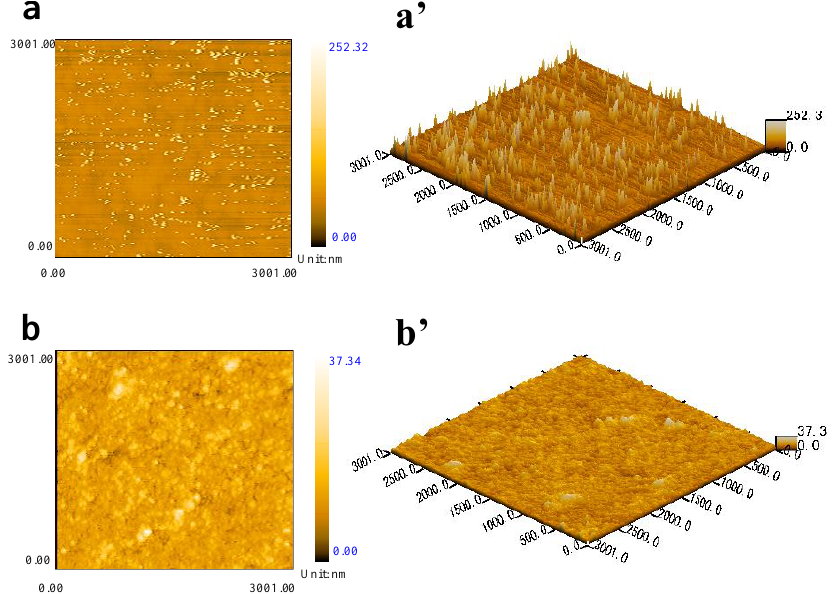
Figure 9. The AFM images of Al@SiO 2 ( a , a′ ) and Al@SiO 2 @PFMV ( b , b′ ).